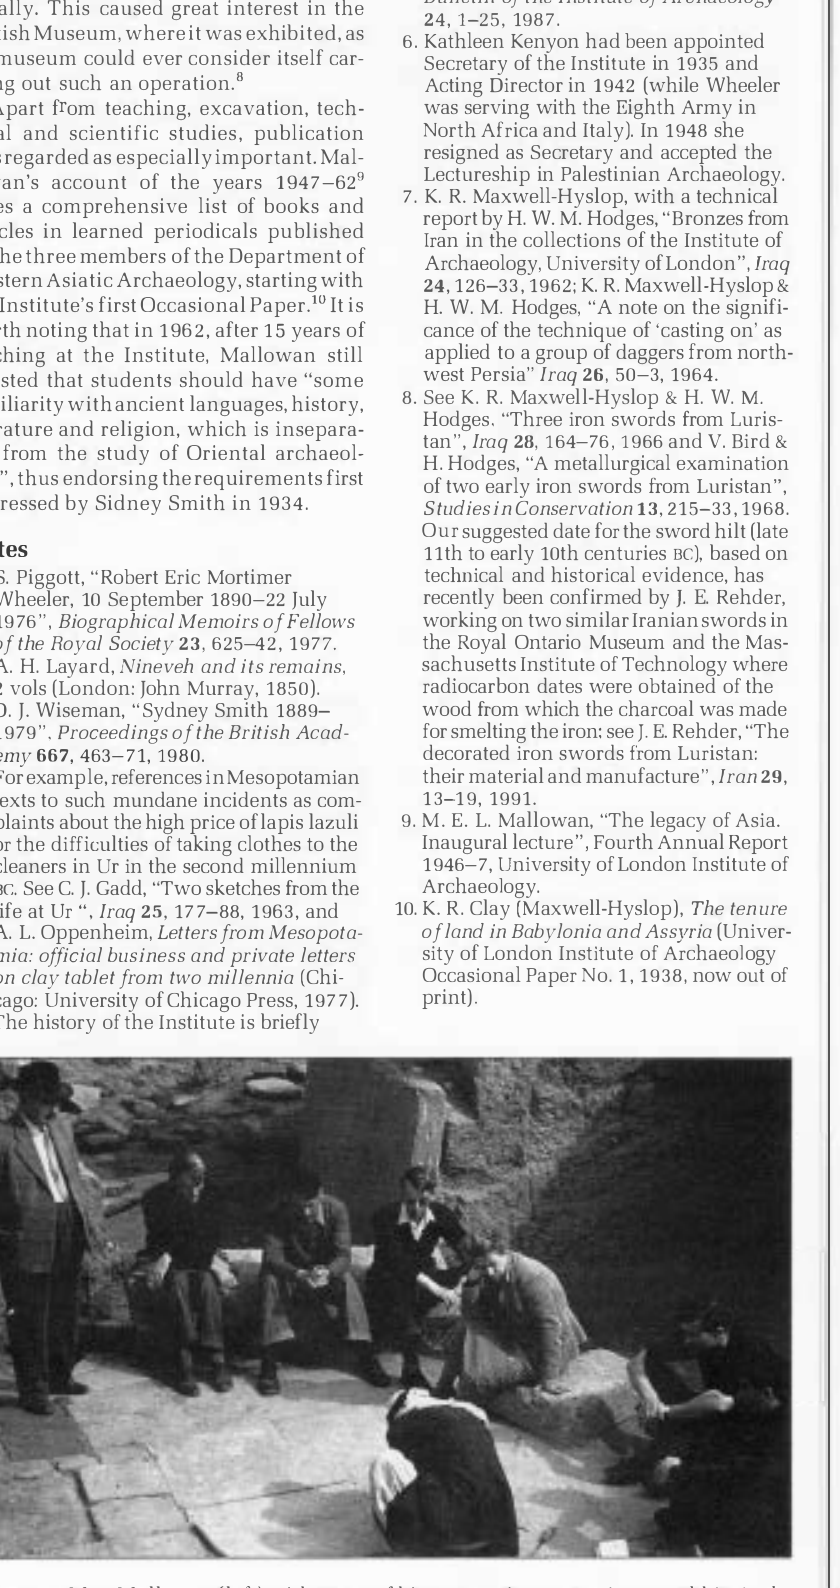
Max Mallowan (left] with some of his excavation supervisors and his Arab foreman at the Nabu temple, Nimrud, in the 1950s.